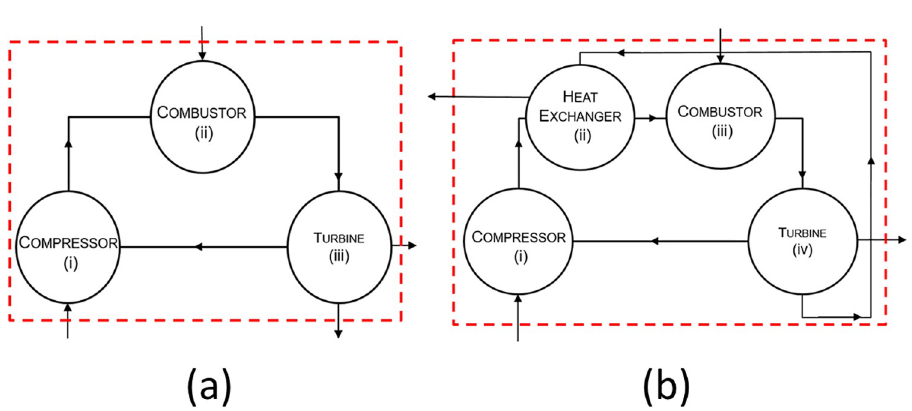
Fig 8. (a) Energy flow diagram for the basic Brayton cycle (B in Table 3) and (b) Energy flow diagram for the Brayton cycle with regeneration (B1 in Table 3). Energy flows are shown between components and across the system boundaries (denoted by dashed